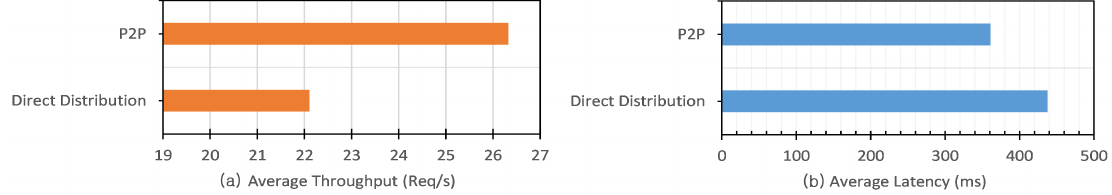
Figure 11. Comparison of average throughput ( a ) and average latency ( b ) in the Check New Version step between direct firmware update and peer-to-peer firmware